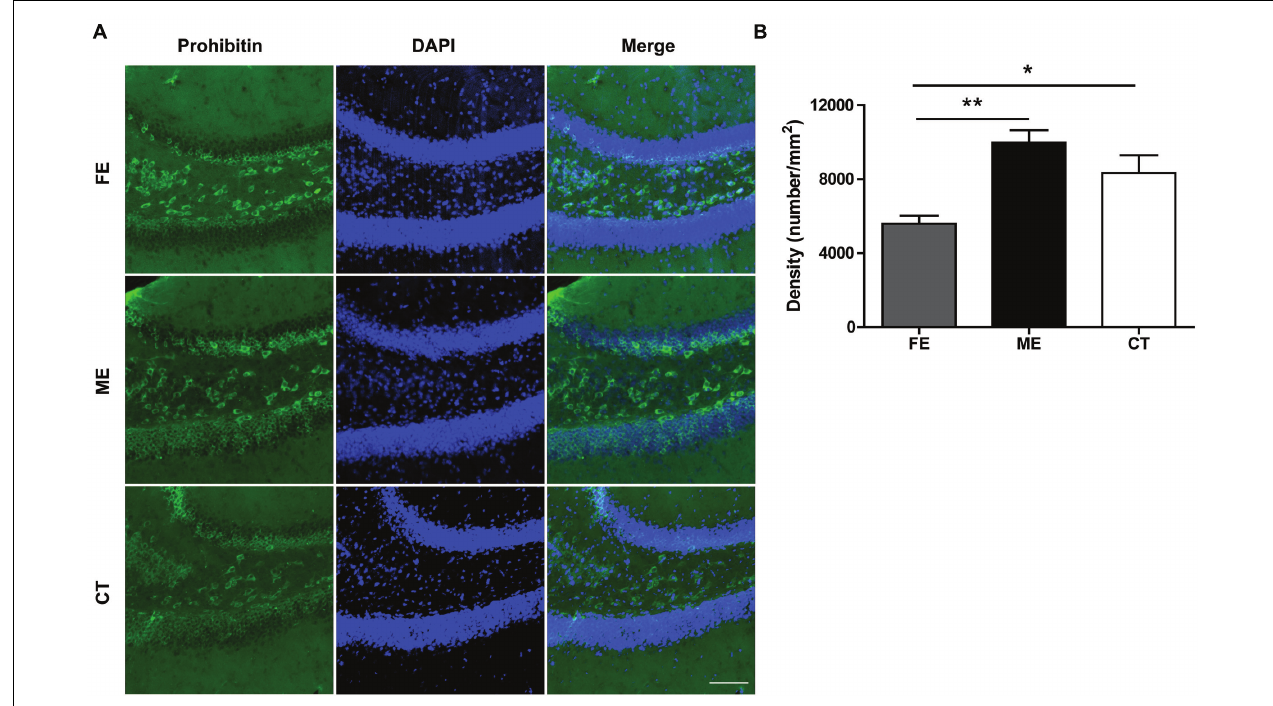
FIGURE 6 | Prohibitin is downregulated in FE mice. (A) Representative images of prohibitin immunoreactivity in the DG regions of FE, ME and CT mice. Scale bar = 100 µ m. (B) Quantification of prohibitin + structures in each group. One-way ANOVA, F 2 , 12 = 9.668, P < 0.0032; post hoc test: ME vs. CT: P > 0.05; ME vs. FE: P < 0.01; FE vs. CT: P > 0.05; n = 5 in each